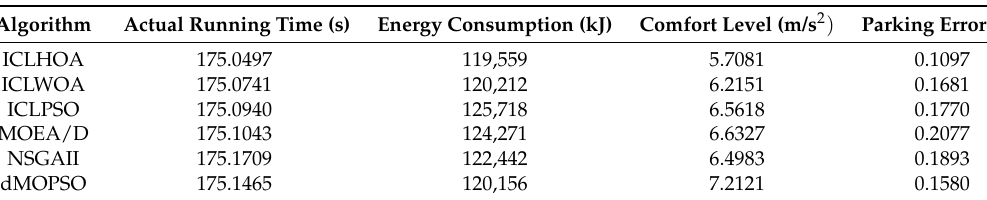
Table 10. Optimization results of velocity ideal trajectory profile obtained by different algorithms in RCL-HILS (peak time period).